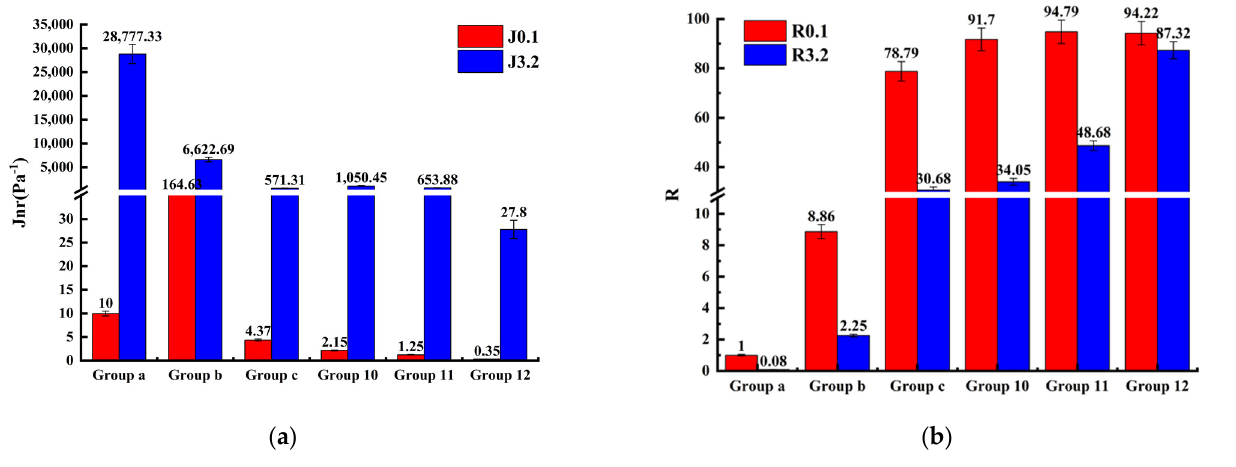
Figure 4. MSCR test results (test temperature: 64 °C). ( a ) The average non-recoverable creep modu- lus; ( b ) the average recovery rate. ( b ) the average recovery